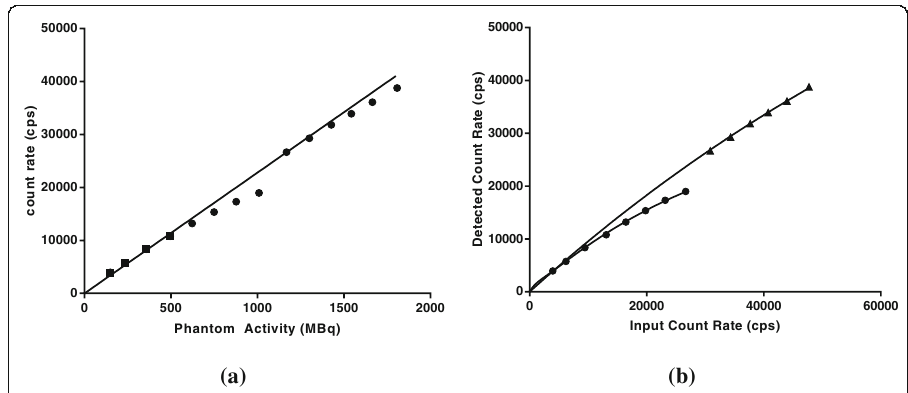
Fig. 3 a Camera dead time data for increasing activities showing linear fit to low activity data points (solid line) and b dead time curve fitted with the appropriate dead time function (solid line)